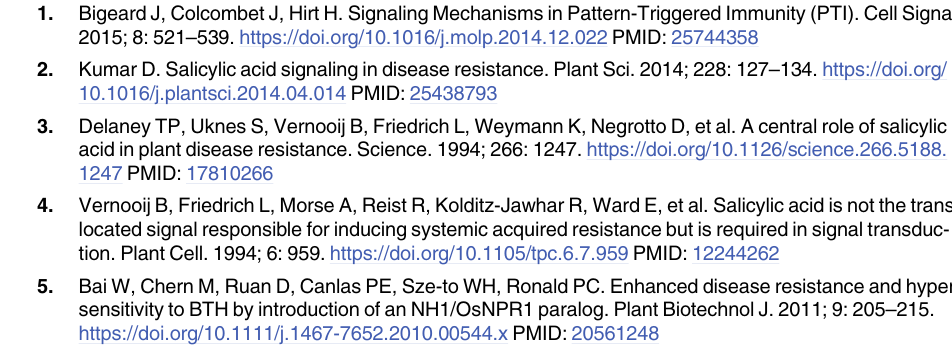
S7 Fig. Microarray analysis of OsTGA2 overexpressing transgenic plants treated with SA. (PDF) S8 Fig. Promoter analysis of responsive genes. The positions of TGA biding site in promoter of responsive genes are marked with the filled circles in red. The number in parentheses indi- cates its transcriptional levels in OsTG A2 overexpressing transgenic plants. (PDF) S9 Fig. Heat map comparing expression of OsTGA genes using microarray data available in Genevestigator database. (A and B) Developmental time course of OsTGA gene expression in rice. Datasets derived from the analysis of tissue-specific gene expression (A) or develop- mental time courses (B) of wild-type plants were used for meta-analysis. (C) Expression of OsTGA s in wild-type plants treated with different phytohormones and infected with various plant disease. S1 Table. List of primers used in this study.